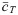
Time traces of the different calcium concentrations for different values of total calcium concentration, c¯T, and calsequestrin concentration set to zero (BSQ = 0).After a transient, the system ends up in either a steady state which is excitatory at low levels of total calcium in the cell with observed low levels of calcium in the cytosol, in an oscillatory state with intermediate levels of total calcium in the cell, or in a state of high total levels of calcium in the cell with observed high cytosolic calcium levels.